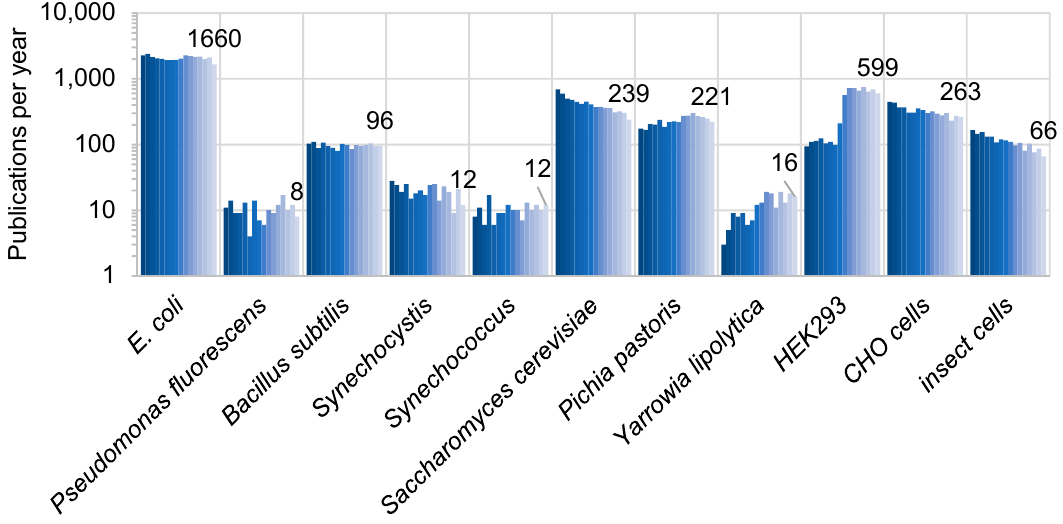
Figure 2. Publications on recombinant proteins in different expression hosts in the last 15 years. The graph shows, as a proxy for the popularity of a particular expression system, the number of publications indexed in the PubMed.gov database from 2003 (dark blue) to 2018 (light blue) that matched the (“X axis label” recombinant protein) search, performed on November 6, 2019. The vertical axis shows a log scale (base 10), and the data labels on the chart represent the 2018 publication count for each host. Only 73 total matches (over 15 years) were found for Ustilago maydis , and are thus not shown in the graph.